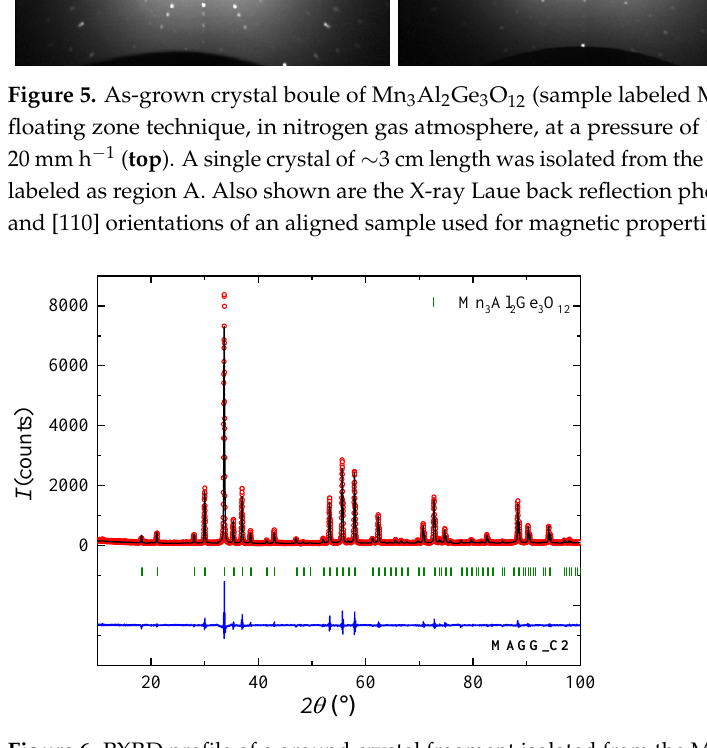
Figure 6. PXRD profile of a ground crystal fragment isolated from the Mn 3 Al 2 Ge 3 O 12 boule (labelled MAGG_C2). The red open circles represent the experimental profile and the black line shows the calculated profile, with the difference given by the blue line. The reflections of the Mn 3 Al 2 Ge 3 O 12 garnet structure are indicated by green “ (cid:120)